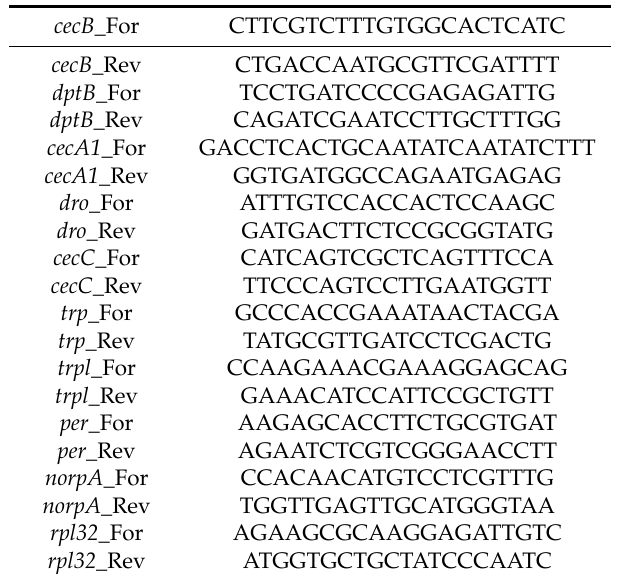
Table 1. Primer sequences used for quantitative PCR (qPCR)